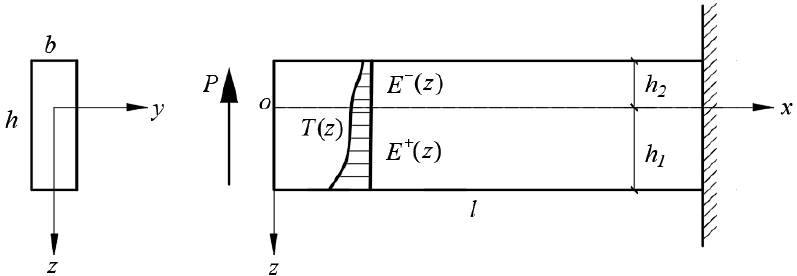
Figure 4. Bimodular FGM cantilever beam under lateral-force bending in thermal